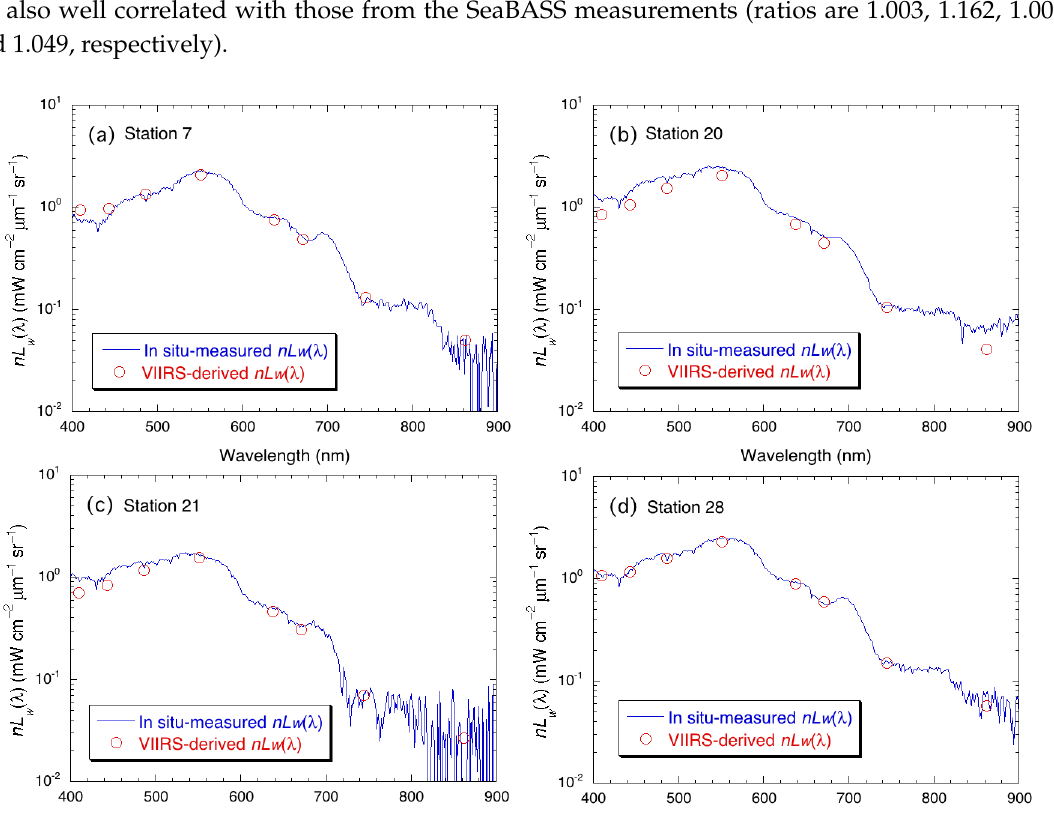
Figure 3a. In addition, ratios of VIIRS-derived nL w ( λ ) at the wavelengths of 443, 486, 638, and 671 nm to nL w (551), which are usually inputs to retrieve water biological and biogeochemical products, are compared with those from the SeaBASS nL w ( λ ) data (Figure 3b). The VIIRS-derived nL w ( λ ) data correspond reasonably well to the in-situ-measured nL w ( λ ), with an overall mean ratio of 1.051. Radiance ratios in nL w ( λ ) of nL w (443) to nL w (551), nL w (486) to nL w (551), nL w (638) to nL w (551), and nL w (671) to nL w (551) from VIIRS retrievals are also well correlated with those from the SeaBASS measurements (ratios are 1.003, 1.162, 1.005, and 1.049, respectively).